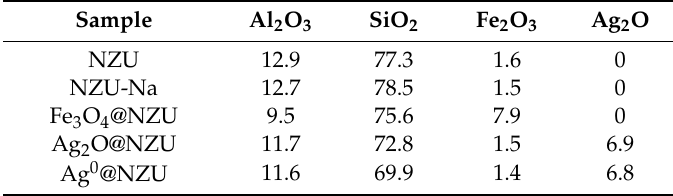
Table 2. X-ray Fluorescence (XRF) results in wt%.